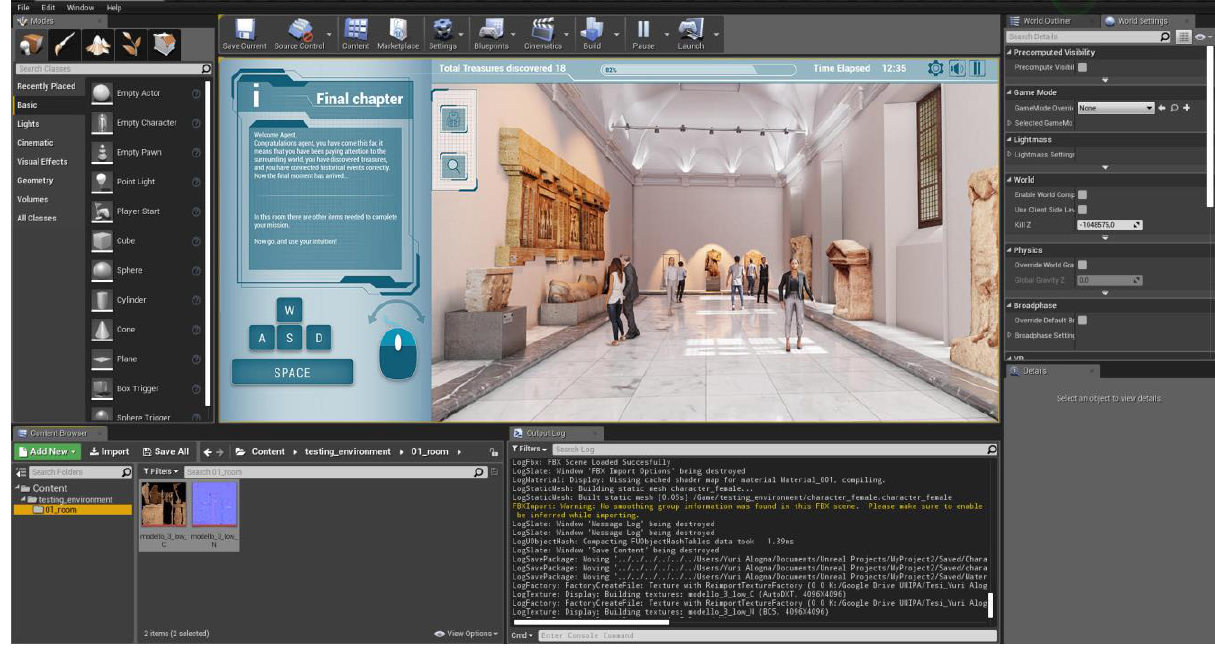
Figure 7. Game environment and play modality for adult target audience. Configuration of the context and of the player's paths within the UnReal Engine 4 platform . Design of the selection and interaction modalities of the contents within the UnReal Engine 4 platform